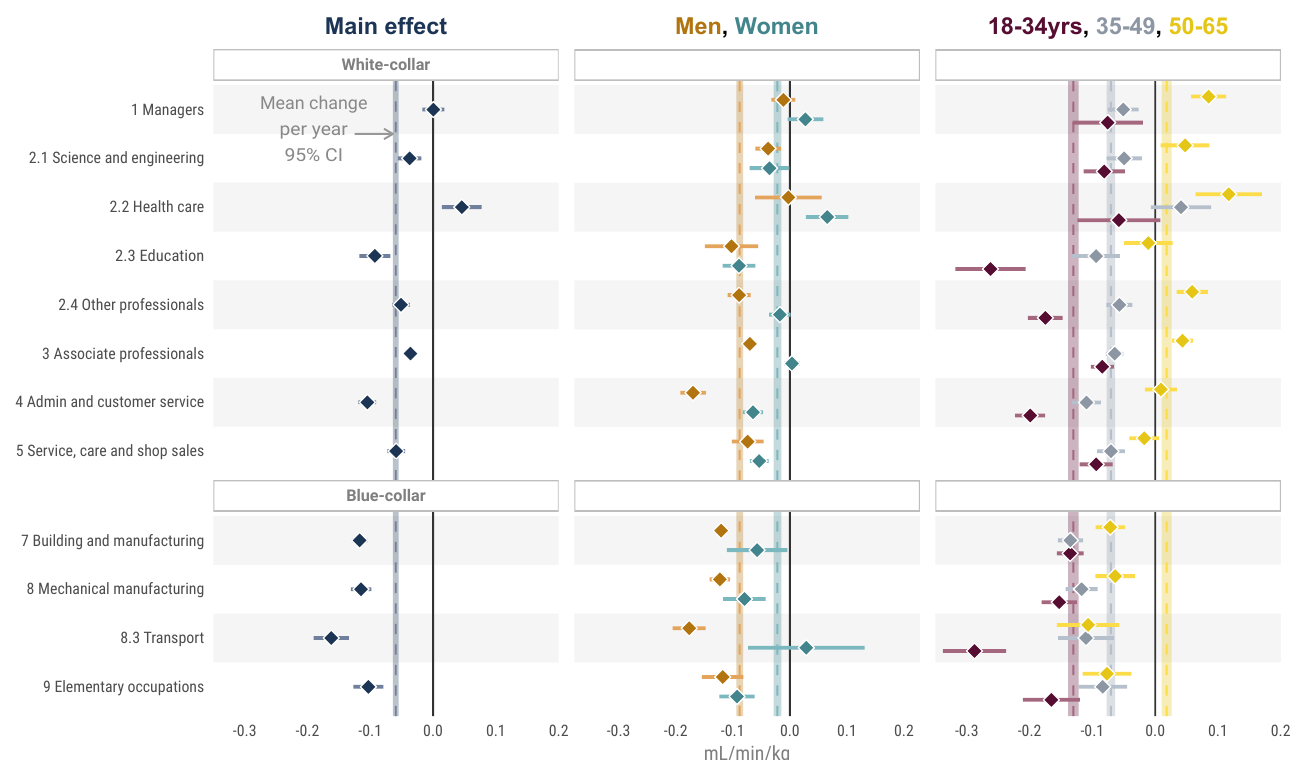
Figure 2. Change in CRF per year in the different occupational groups, both in the total study population and in relation to sex and age-group. Vertical lines are mean annual change in CRF in the total study population (black, thin line) and in relation to each sex and age-group (same color as assigned to each sub-group, respectively).